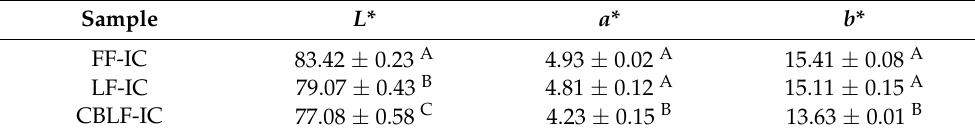
Table 6. Color properties of the control ice cream mixtures and optimum ice cream mixture containing